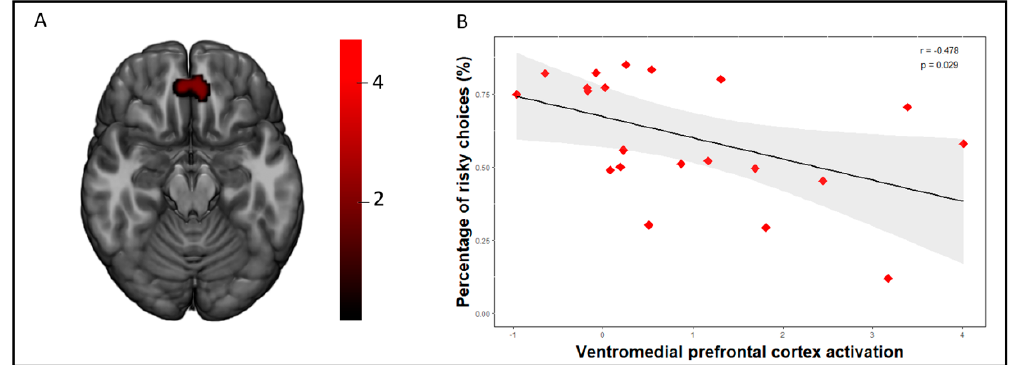
Figure 2. ( a ) Decreased activation was found in the ventromedial prefrontal cortex (vmPFC) in the obesity group compared to the healthy control group (AlphaSim voxel level probability = p < 0.001, p < 0.05 FWE cluster-extent corrected) on the Risky Gains Task during the safe choices vs. risky choices following a loss contrast. Color bar represents t-values. ( b ) A scatterplot depicting the negative correlation between extracted activation eigenvalues from the vmPFC peak and percentage of total risky choices during the task in the obesity group ( n = 21, (r (21) = − 0.478, p = 0.029)).